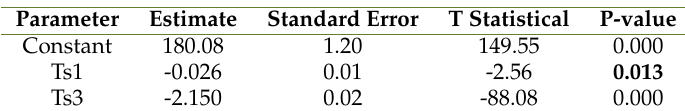
Fig. 1. SRI 3 means graph of the color variable, according to Fisher’s LSD method (95% IC). Sources: Author’s own work. Table 5. Independent variables with p < 0.05 . Sources: Author’s own